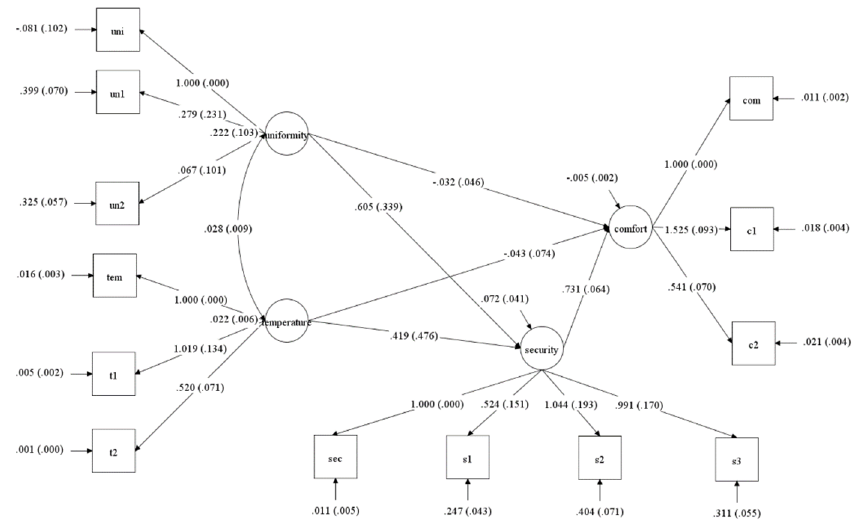
Figure 14. Run results of the comfort evaluation model. Table 3. The results of the hypothetical comfort evaluation